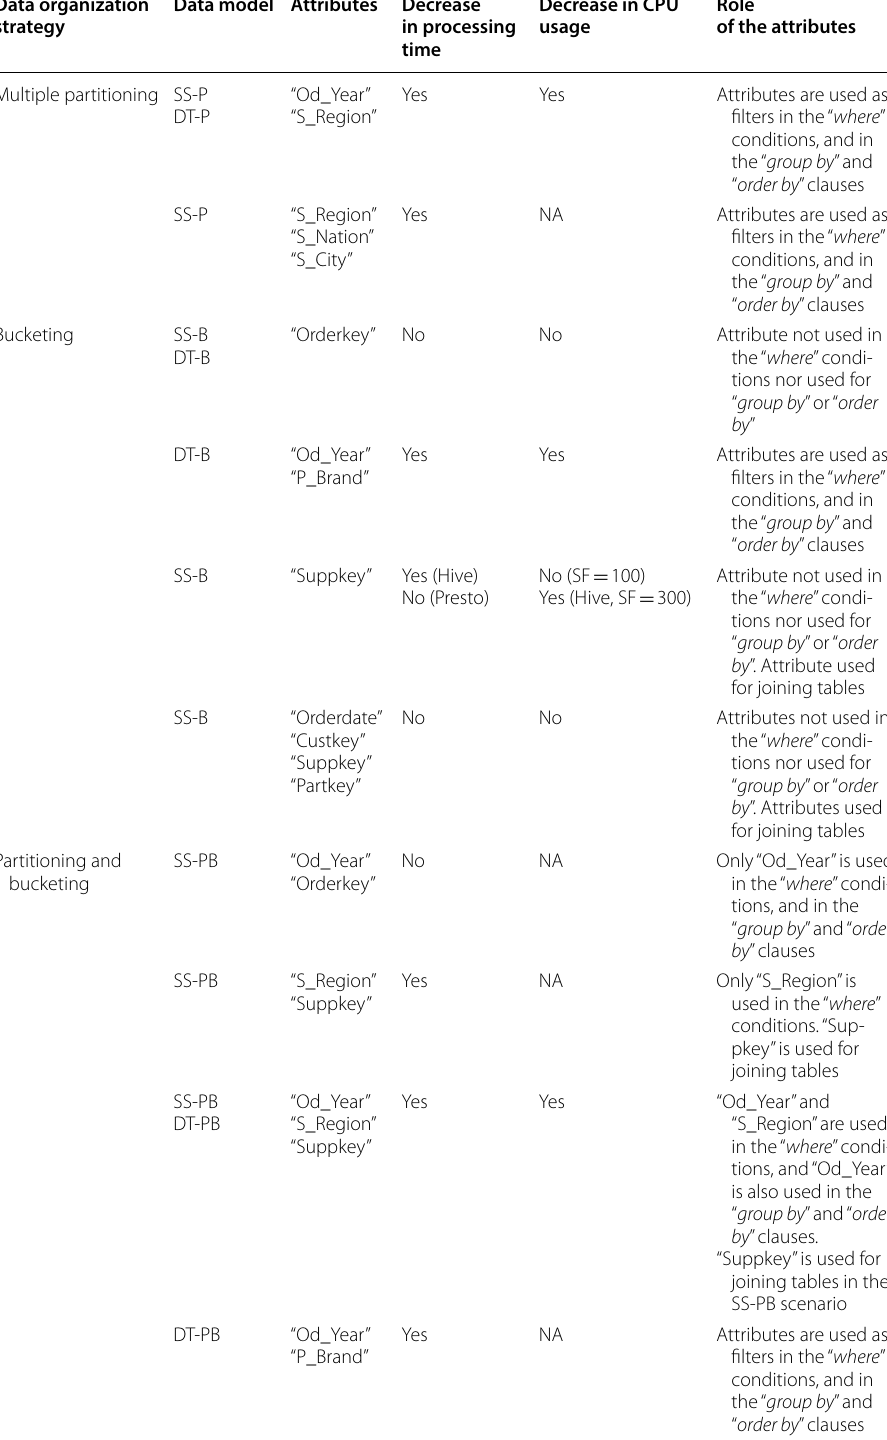
Table 21 Role of the attributes in the data organization strategies and their impact on processing time and CPU